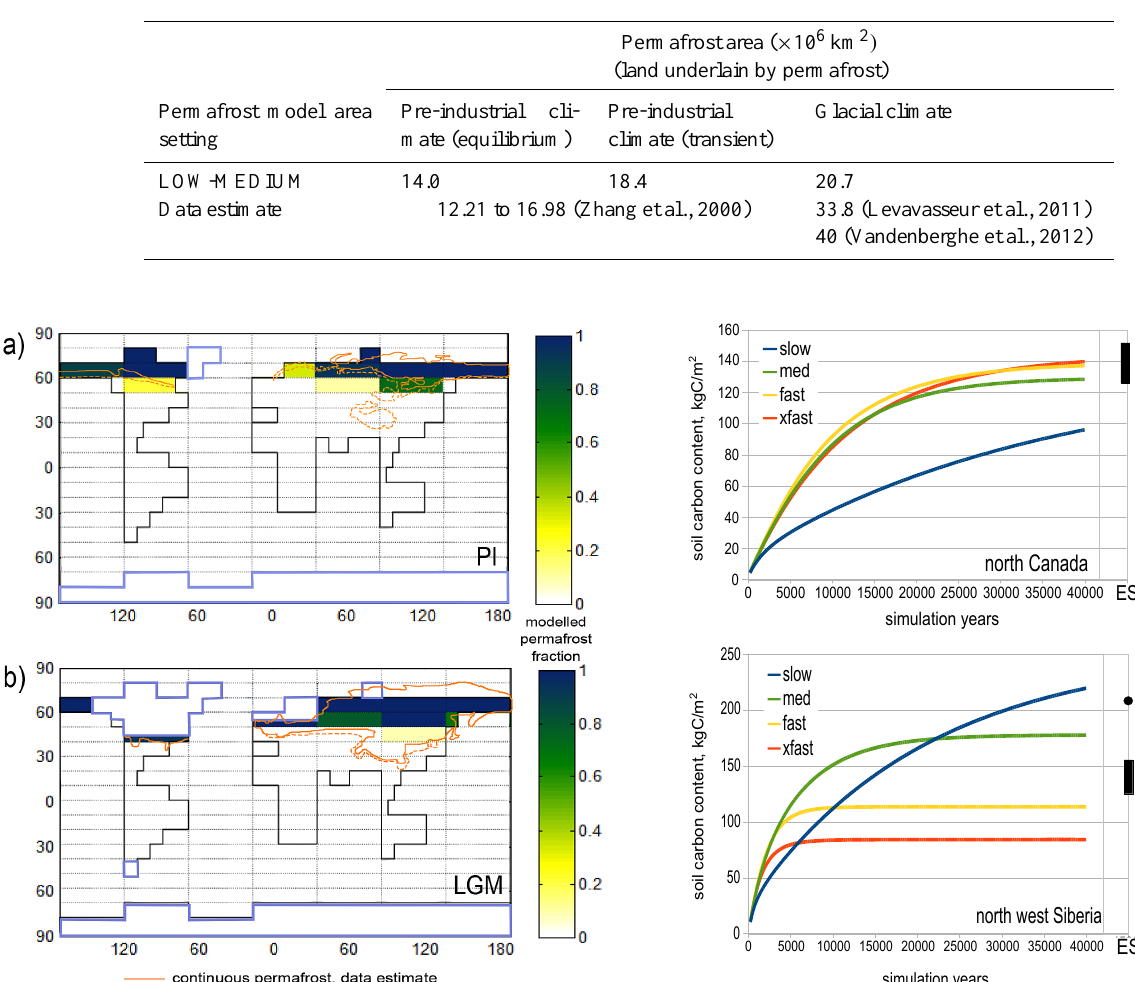
Table 4. Modelled permafrost-affected land area and data-based estimates.